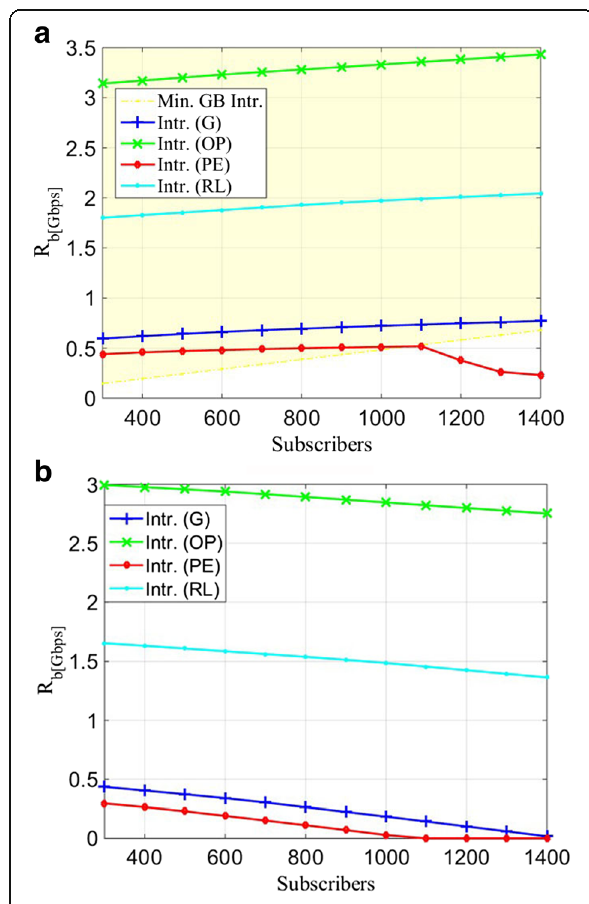
Fig. 11 The data rate allocated to the interactive class. a VNO BG.